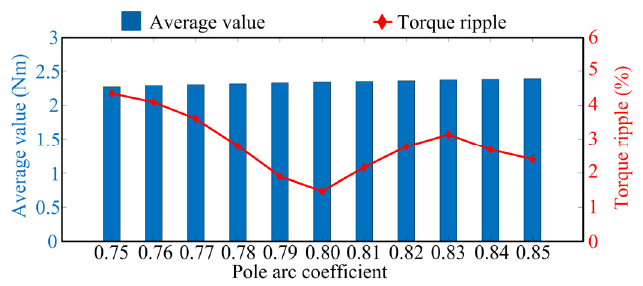
Figure 13. Effect of pole arc coefficient on electromagnetic torque in a machine with 10-pole and 21-slot.